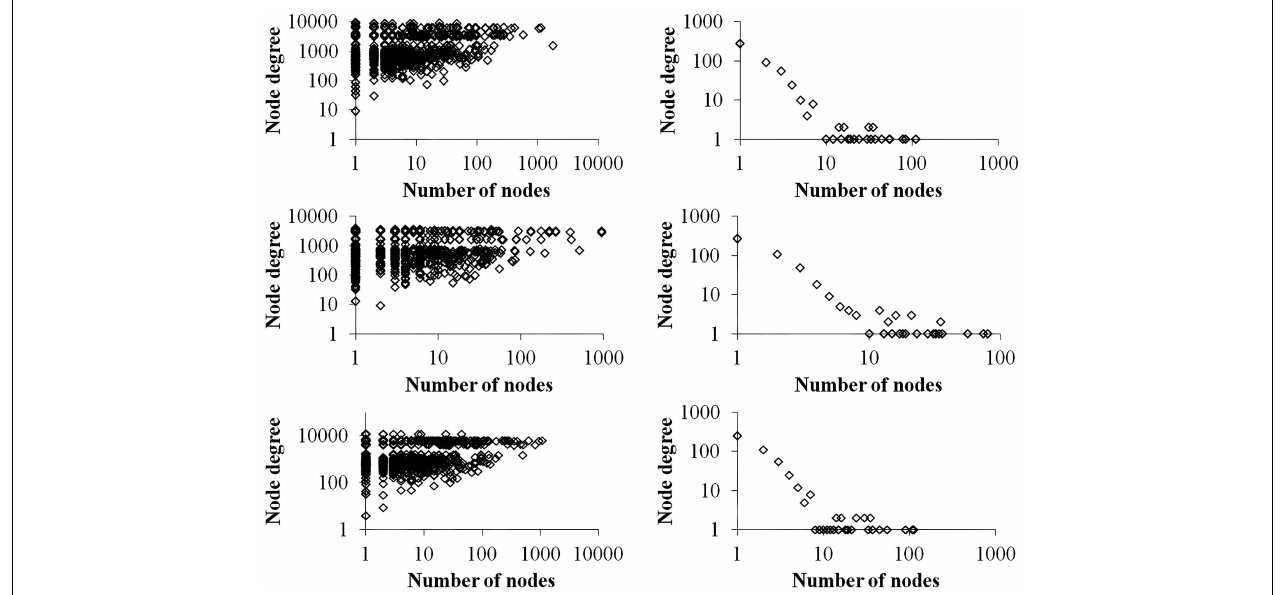
FIGURE 4 | A plot of the number of nodes (vertical axis) vs. the cumulative degrees (horizontal axis) of VMNs (left) as compared to their respective GRNs (right) .